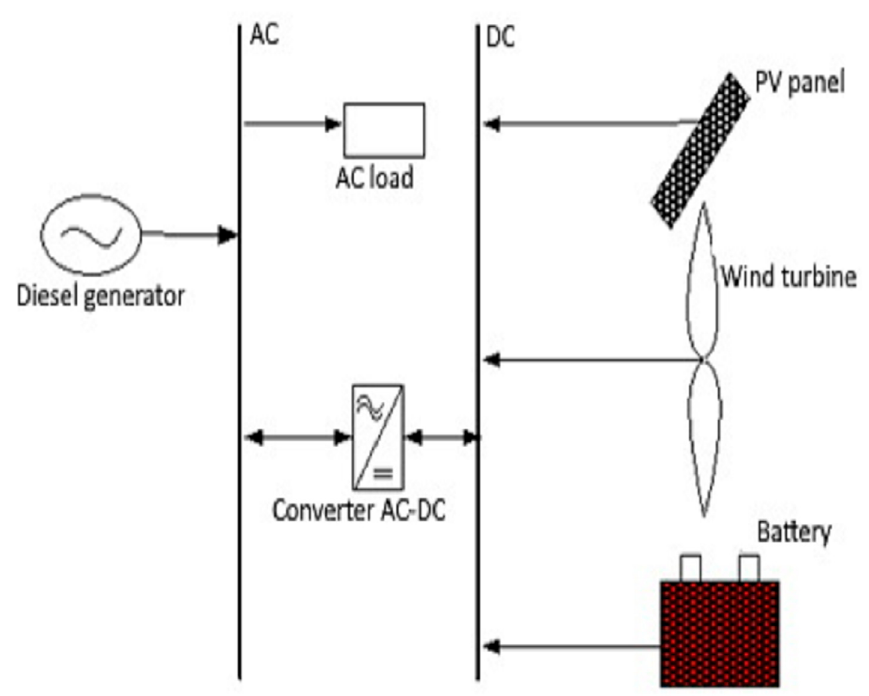
Figure 1. DC–AC configuration for a hybrid system based on renewable sources.